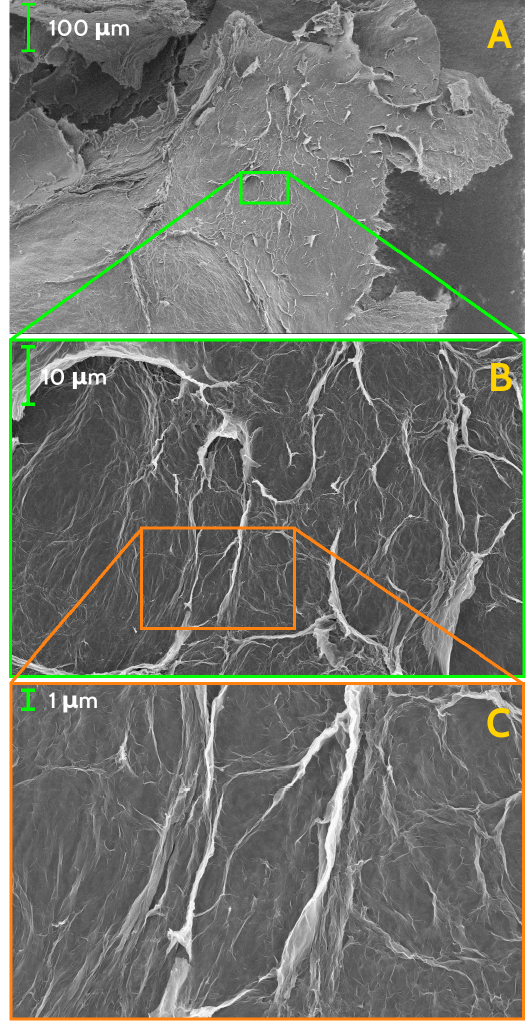
Figure 2. SEM images of the investigated GS, at different scale of magnification: ( A ) 244 × , ( B ) 2000 × , and ( C ) 10,000 × . Long and compact lamellar structures are visible, closed in irregular